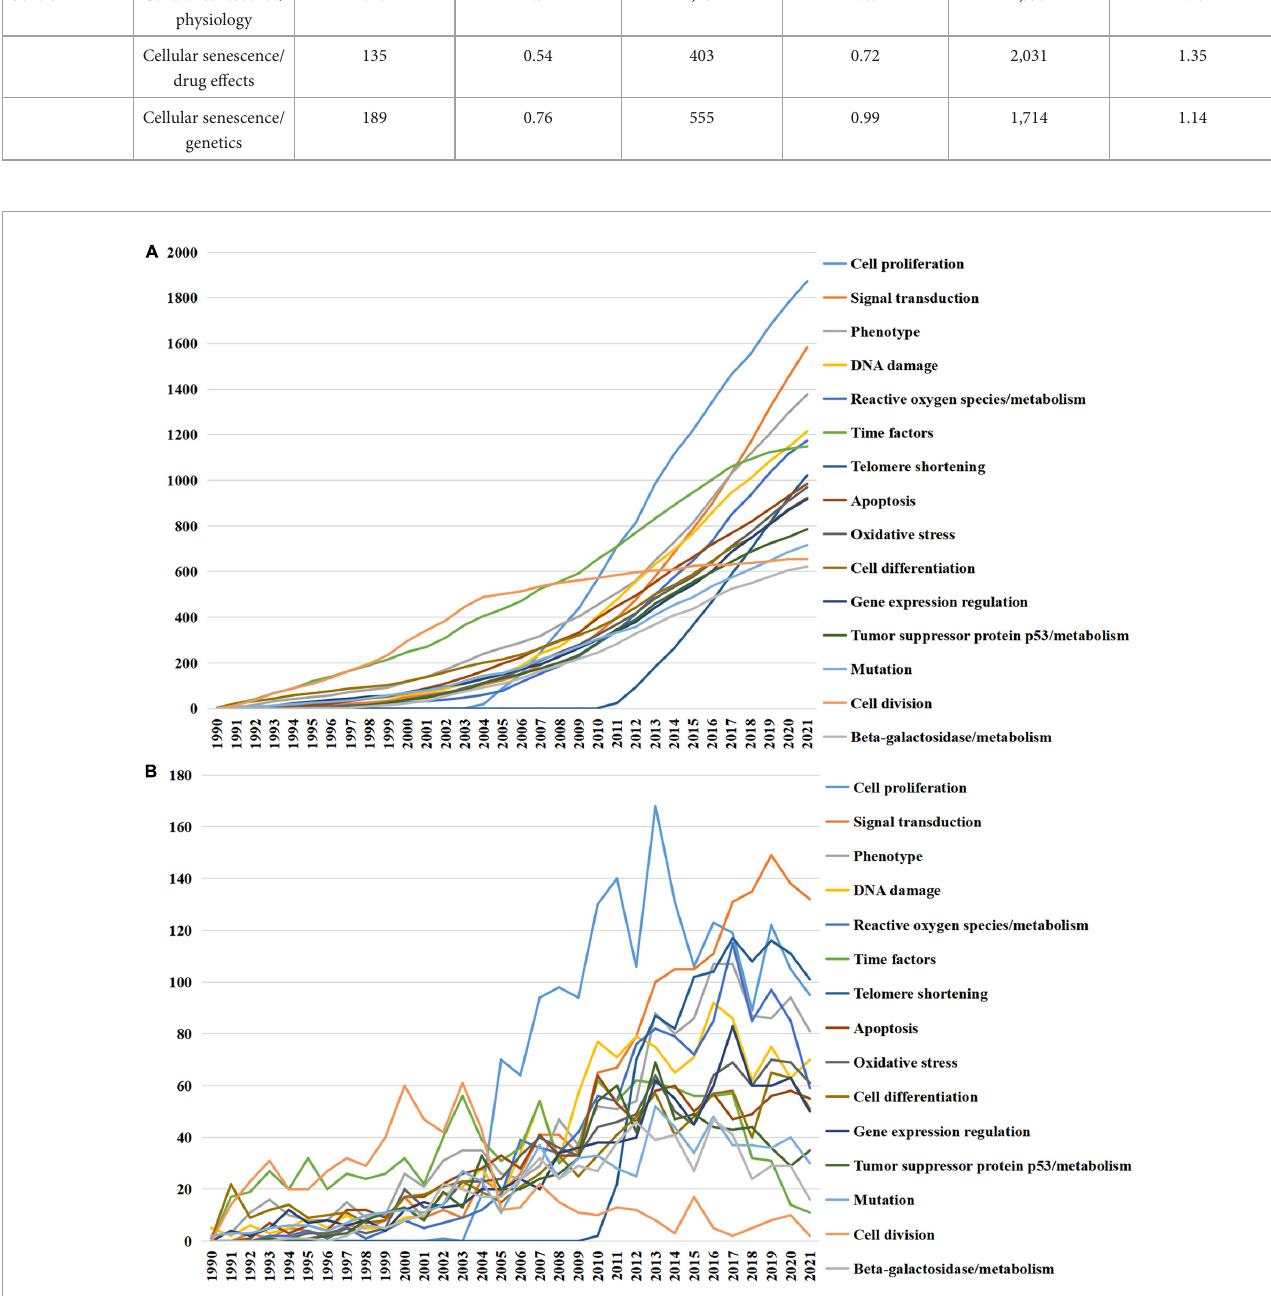
FIGURE4 Top 15 medical subject headings (MeSH) terms related to the pathogenesis of cellular senescence. (A) Accumulated occurrences; (B) annual occurrences.